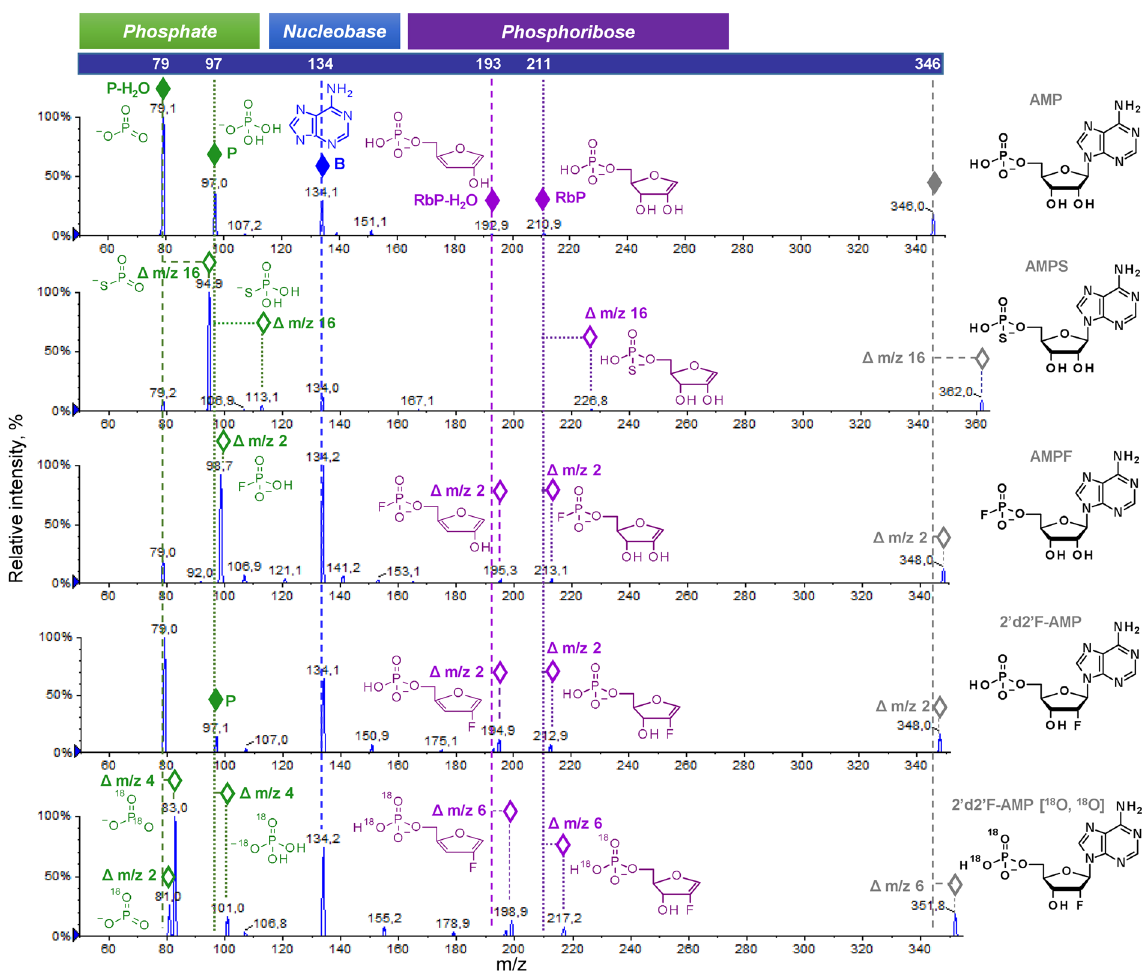
Figure 3. Analysis of phosphate- and ribose-modified AMP analogues by ESI( − )/MS/MS. In each spectrum, fragmentation ions enabling determination of the substitution site (nucleobase versus phosphate versus ribose) are indicated with diamonds ( ◊ ) and their proposed structures are